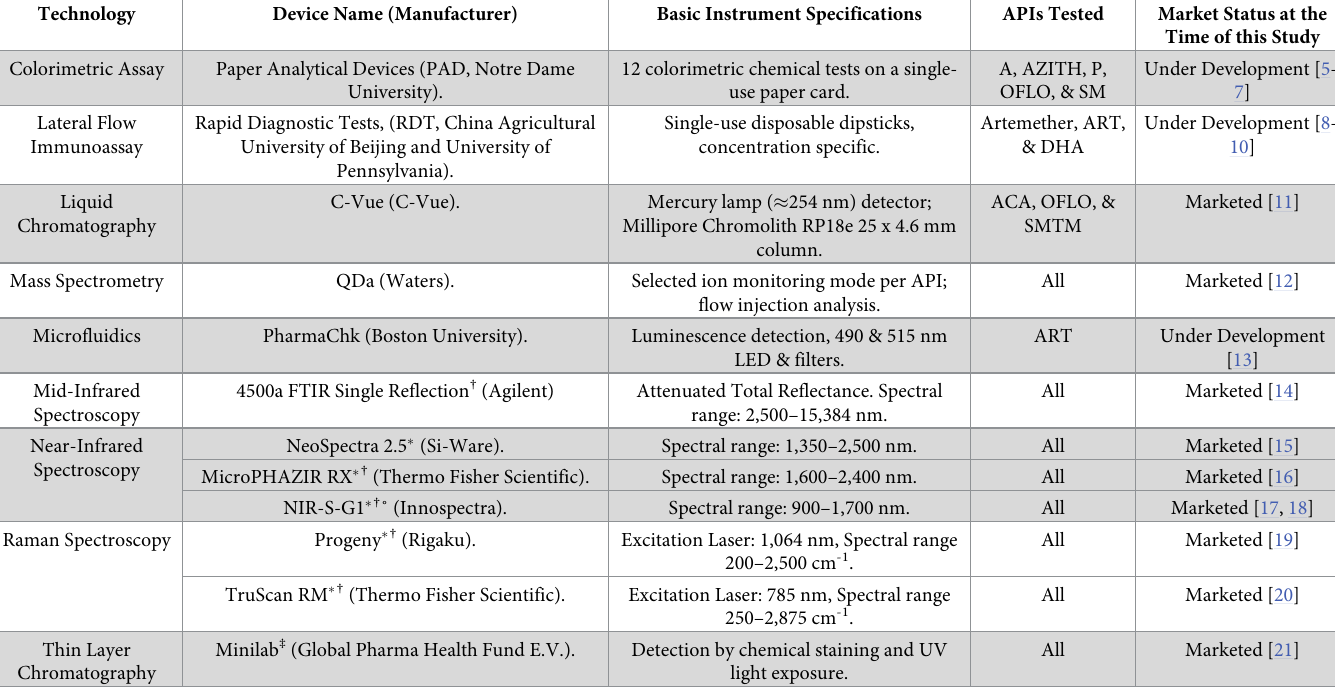
Table 1. List of instruments and devices evaluated, including their underlying technology and basic instrument